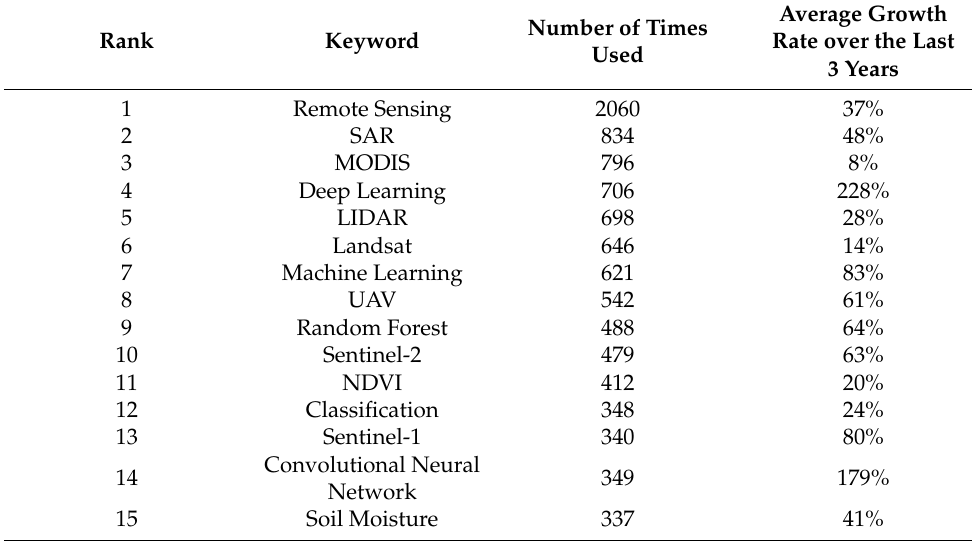
Table 3. Number of times that keywords are used in articles published in Remote Sensing and average growth rate for the last three years sorted by the number of keywords.